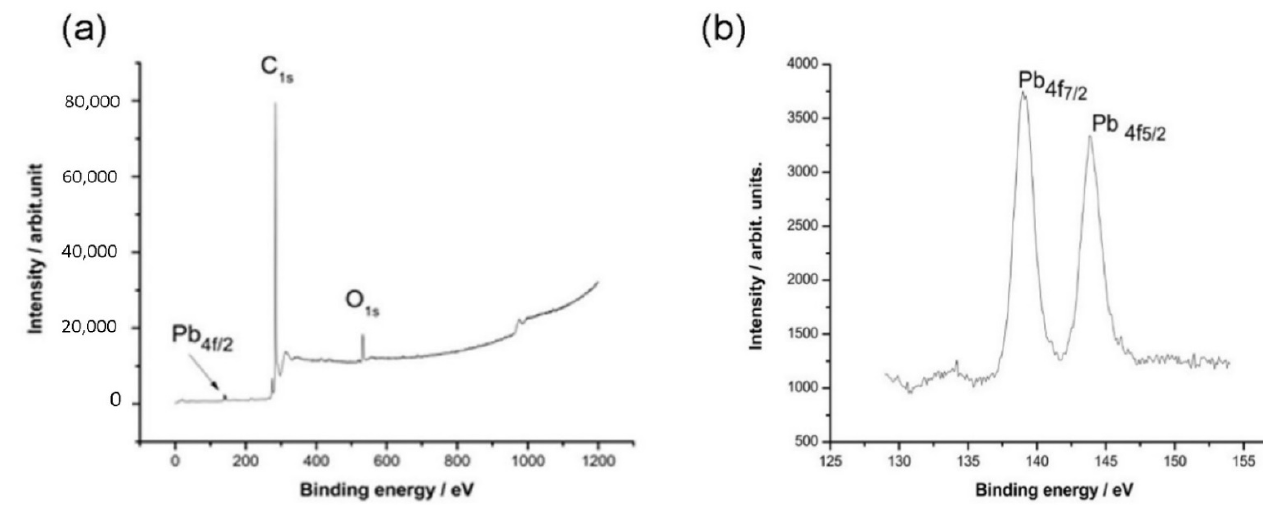
Figure 4. XPS spectra of oxidized graphite powder after exposure to Pb 2+ with the scan range of ( a ) 0–1200 eV and ( b ) 130–155 eV.